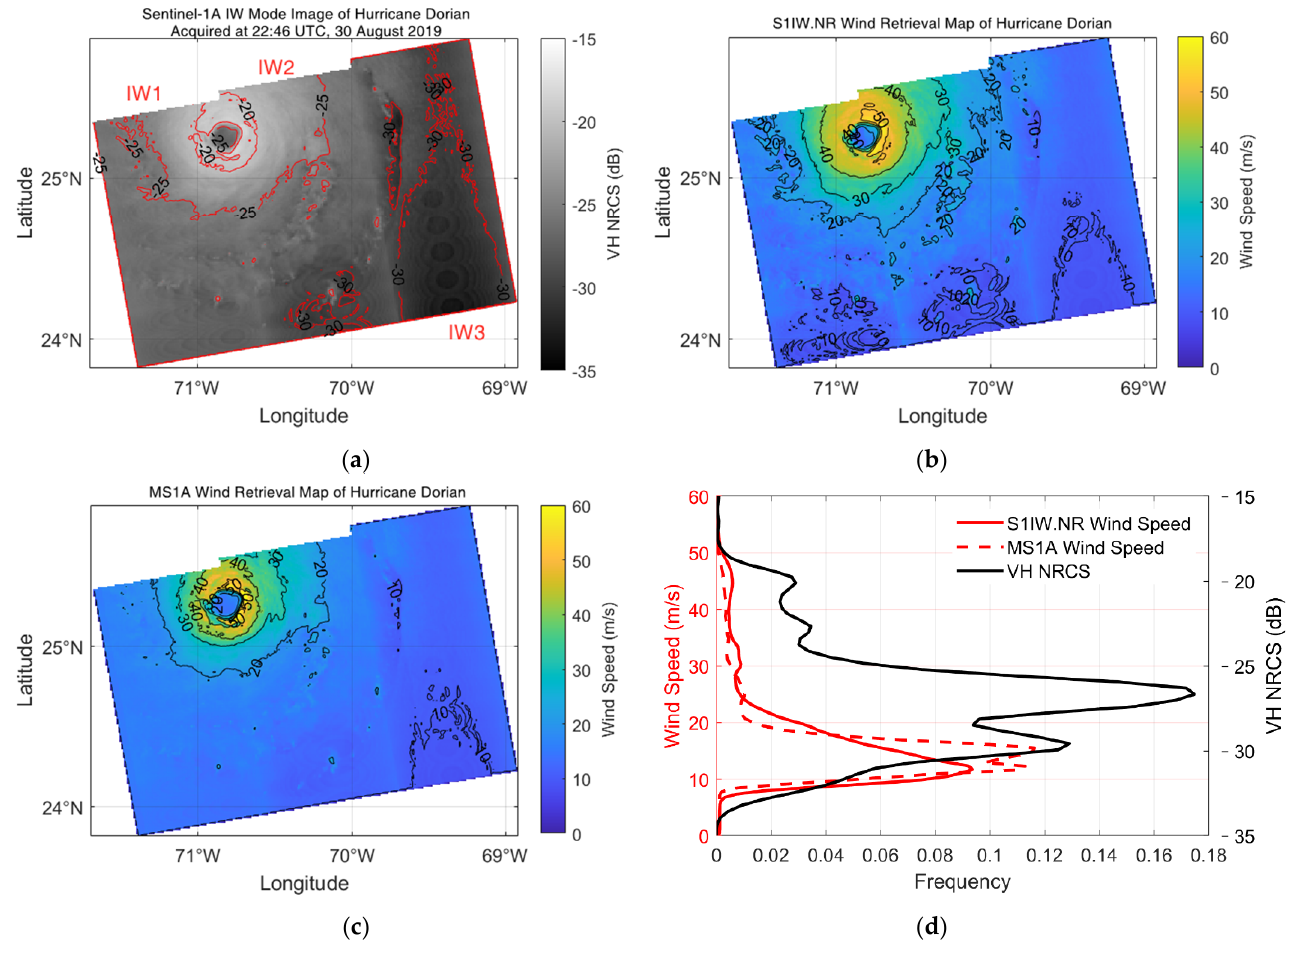
Figure 7. ( a ) S1A IW mode VH-polarization image of Hurricane Dorian acquired at 22:46 UTC 30 August 2019. Wind speed retrievals of Hurricane Dorian using ( b ) the S1IW.NR model and ( c ) the MS1A model. ( d ) The probability density distribution of VH NRCS in ( a ) and wind speeds in ( b ) and ( c ). In ( d ), the red solid curve and red dashed curve stand for the wind speeds retrieved by S1IW.NR and MS1A, corresponding to the left Y-axis. Black curve stands for the VH NRCS, corresponding to the right Y-axis.